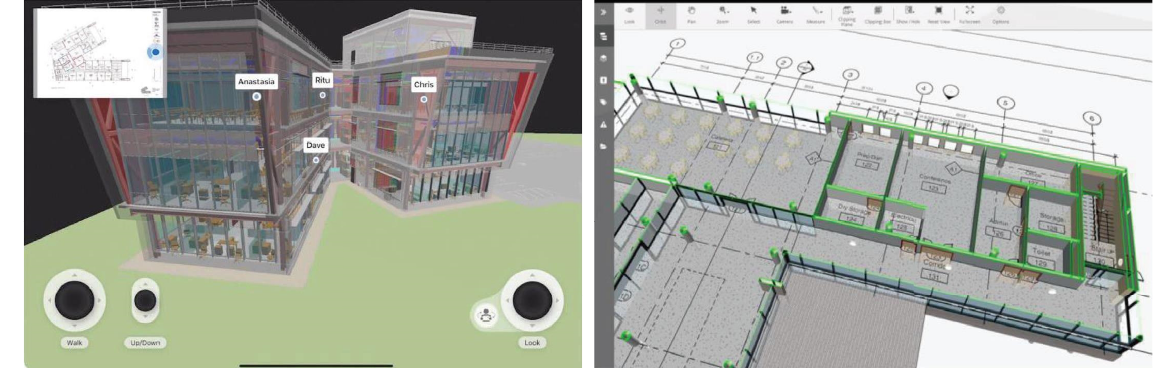
Figure 3: Building information model of a building and the construction